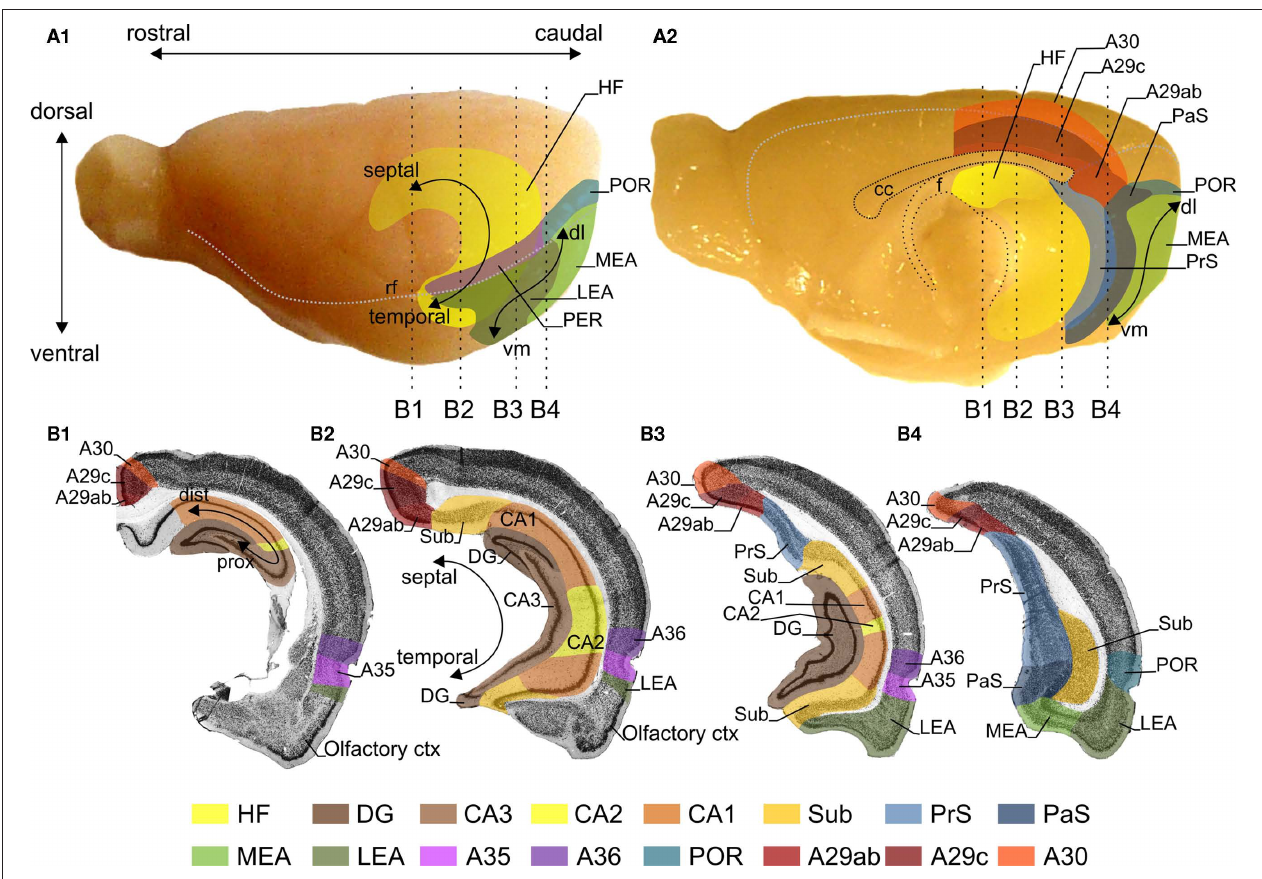
the proximodistal axis which indicates a position closer to DG or closer to PHR, respectively (B1) . The main axis applied in case of PrS and PaS is also the septotemporal axis, in PER and POR a rostrocaudal axis and in the entorhinal cortex is a dorsolateral-to-ventromedial axis [dl and vm; (A1,A2) ]. The dashed vertical lines in panels (A1,A2) indicate the levels of four coronal sections (B1–B4) , which are shown in (B) . The gray stippled line in (A1) represents the position of the rhinal fissure (rf) and in (A2) they represent the global delineation from the dorsal surface of the brain with the midsagittal and occipital surfaces. (B) Four coronal sections of the rat brain; the levels of these sections are indicated in (A) . The subfields of the HF, PHR and RSC are color-coded, see color panel below (B)